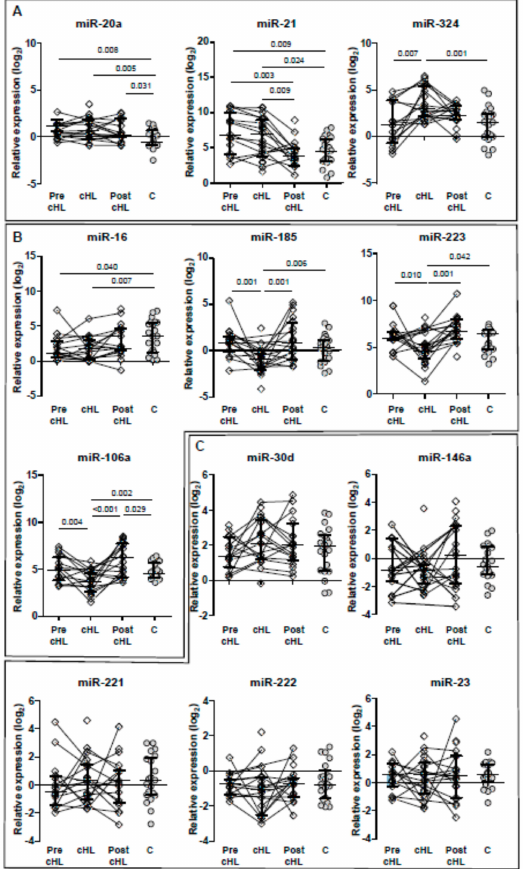
Figure 1. Relative expression of miRs before cHL (Pre-cHL), at cHL diagnosis (cHL) and post-chemotherapy (Pst-cHL), and in individuals with no cHL (Controls, C). A, miRs over-regulated at cHL diagnosis compared to controls; B, miRs down-regulated at cHL diagnosis compared to controls; and C, miRs with no di ff erences in expression compared to controls. Paired-samples are represented by continuous lines. Only significant p < 0.05 values are shown (Mann-Whitney U